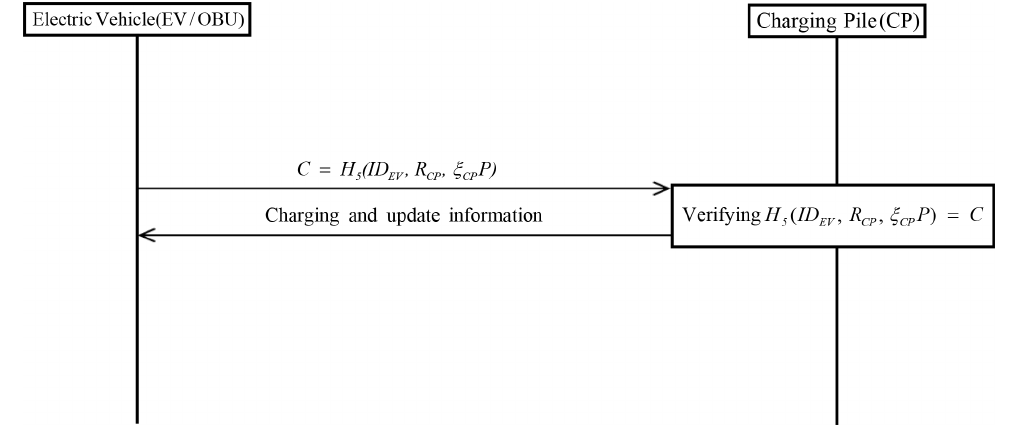
Figure 5. Charging phase of Huang et al.’s